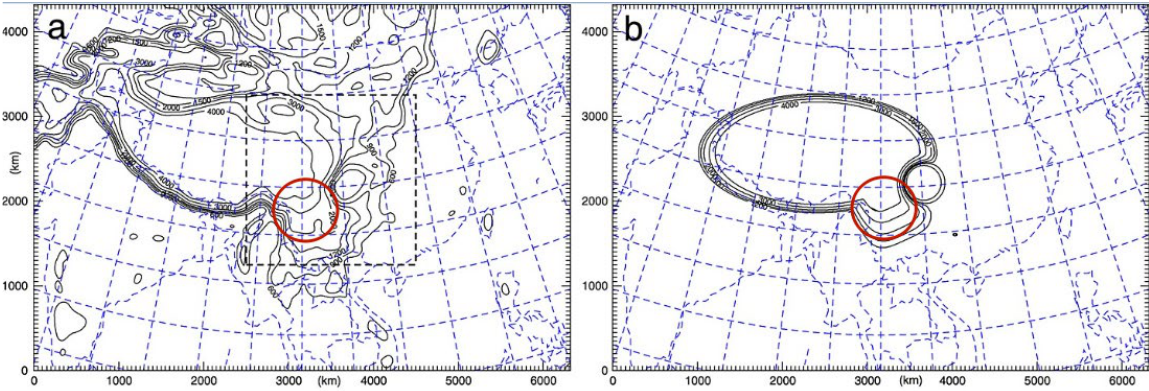
Figure 1. The profiles of the body of detouring flow at 700 hPa (marked with red cycle): ( a ) the actual and ( b ) ideal profiles of the Tibetan Plateau and Hengduan Mountains at 700 hPa [18]. Reprinted with permission from ref. [18]. Copyright Year: 2014; Copyright Owner’s Name: Qiwei Wang.